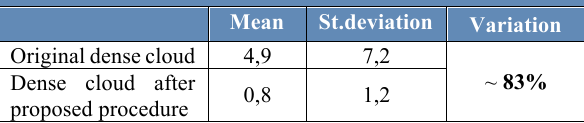
Table 4: Average cloud-to-cloud distance variation (cm) evaluated on 5 sub-areas.